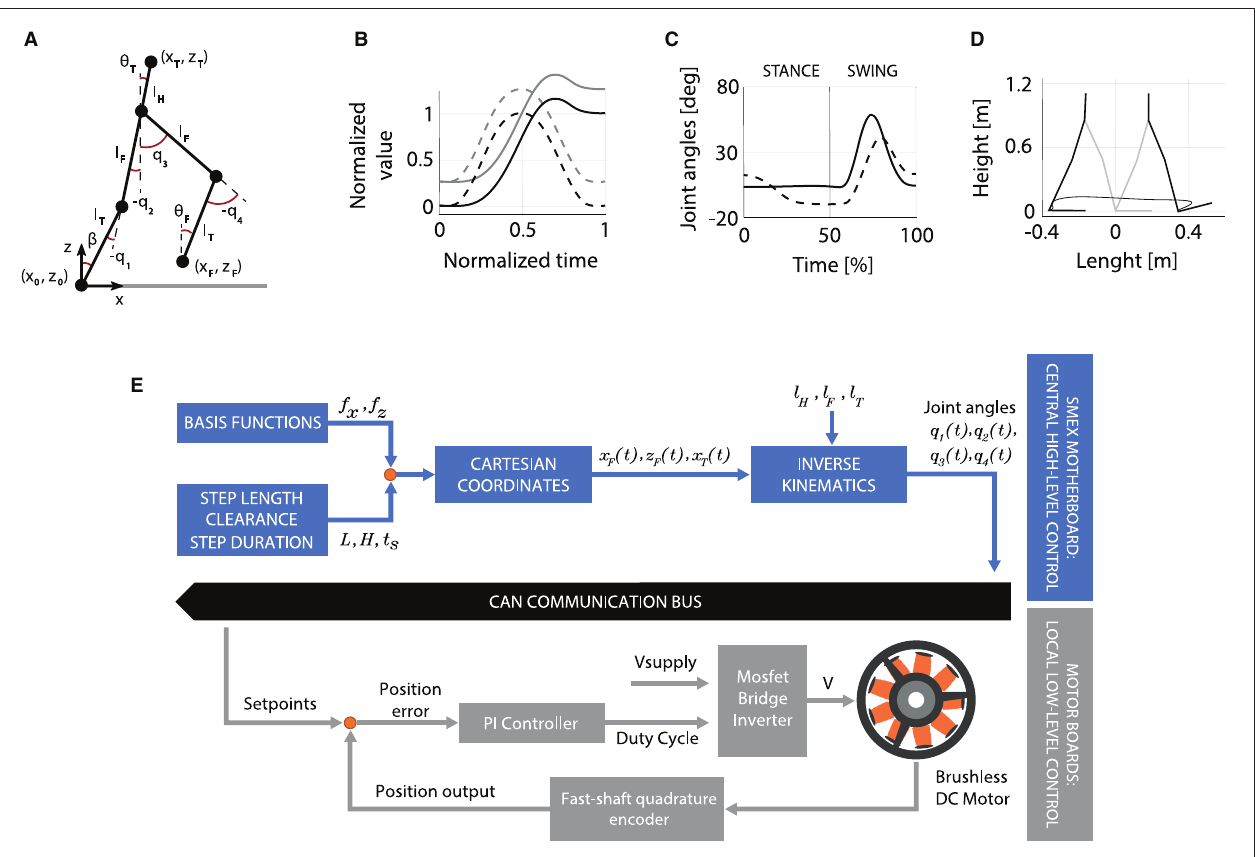
FIGURE 9 | (A) The kinematic model of TWIN. (B) The basis functions f x and f z are represented by the continuous and dashed lines, respectively. (C) Reference joint trajectories, in position control, during a stride. (D) Cartesian trajectory of the swing foot during a step. In (C) and (D) plots, the step is ∼ 0.8m long with a peak height of ∼ 0.20m. (E) Conceptual block scheme showing the control architecture of the TWIN